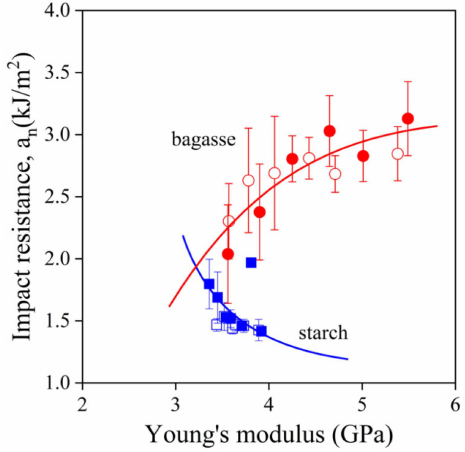
Figure 9. Correlation of the stiffness and impact strength of PLA composites reinforced with starch Figure 2. Composition dependence of the stiffness of PLA composites reinforced with starch or ba- Figure 2. Composition dependence of the stiffness of PLA composites reinforced with starch or ba- and sugarcane bagasse fibers. Opposing effects as a result of different local processes. Symbols: ( gasse fibers. Effect of coupling. Symbols: (  ,  ) sugarcane bagasse fibers, (  ,  ) starch; empty gasse fibers. Effect of coupling. Symbols: (  ,  ) sugarcane bagasse fibers, (  ,  ) starch; empty Figure 2. Composition dependence of the stiffness of PLA composites reinforced with starch or ba- Figure 2. Composition dependence of the stiffness of PLA composites reinforced with starch or ba- symbols without MAPLA, full symbols with MAPLA. symbols without MAPLA, full symbols with MAPLA. , ) starch; empty symbols without MAPLA, full symbols with gasse fibers. Effect of coupling. Symbols: (  ,  ) sugarcane bagasse fibers, (  ,  ) starch; empty gasse fibers. Effect of coupling. Symbols: (  ,  ) sugarcane bagasse fibers, (  ,  ) starch; empty symbols without MAPLA, full symbols with MAPLA. symbols without MAPLA, full symbols with MAPLA.